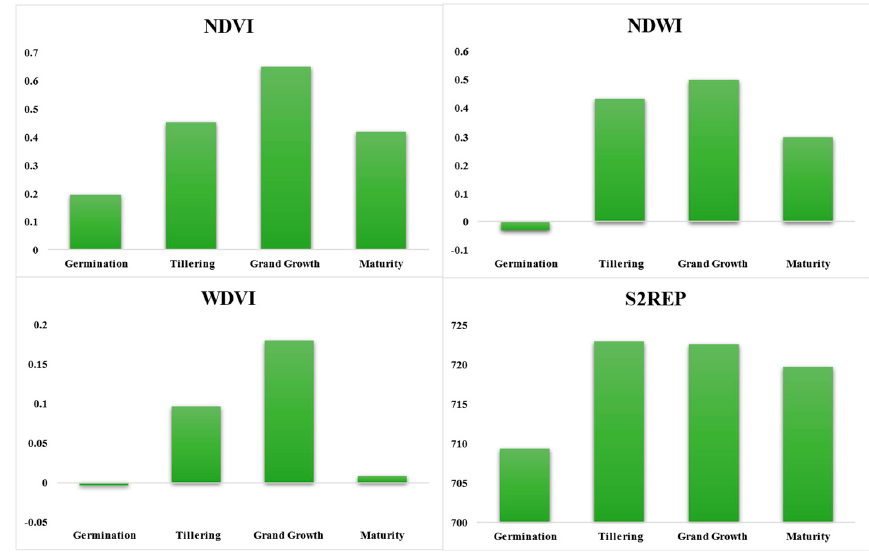
Figure 7. Response of Sentinel-2 indices with respect to phenology stages.